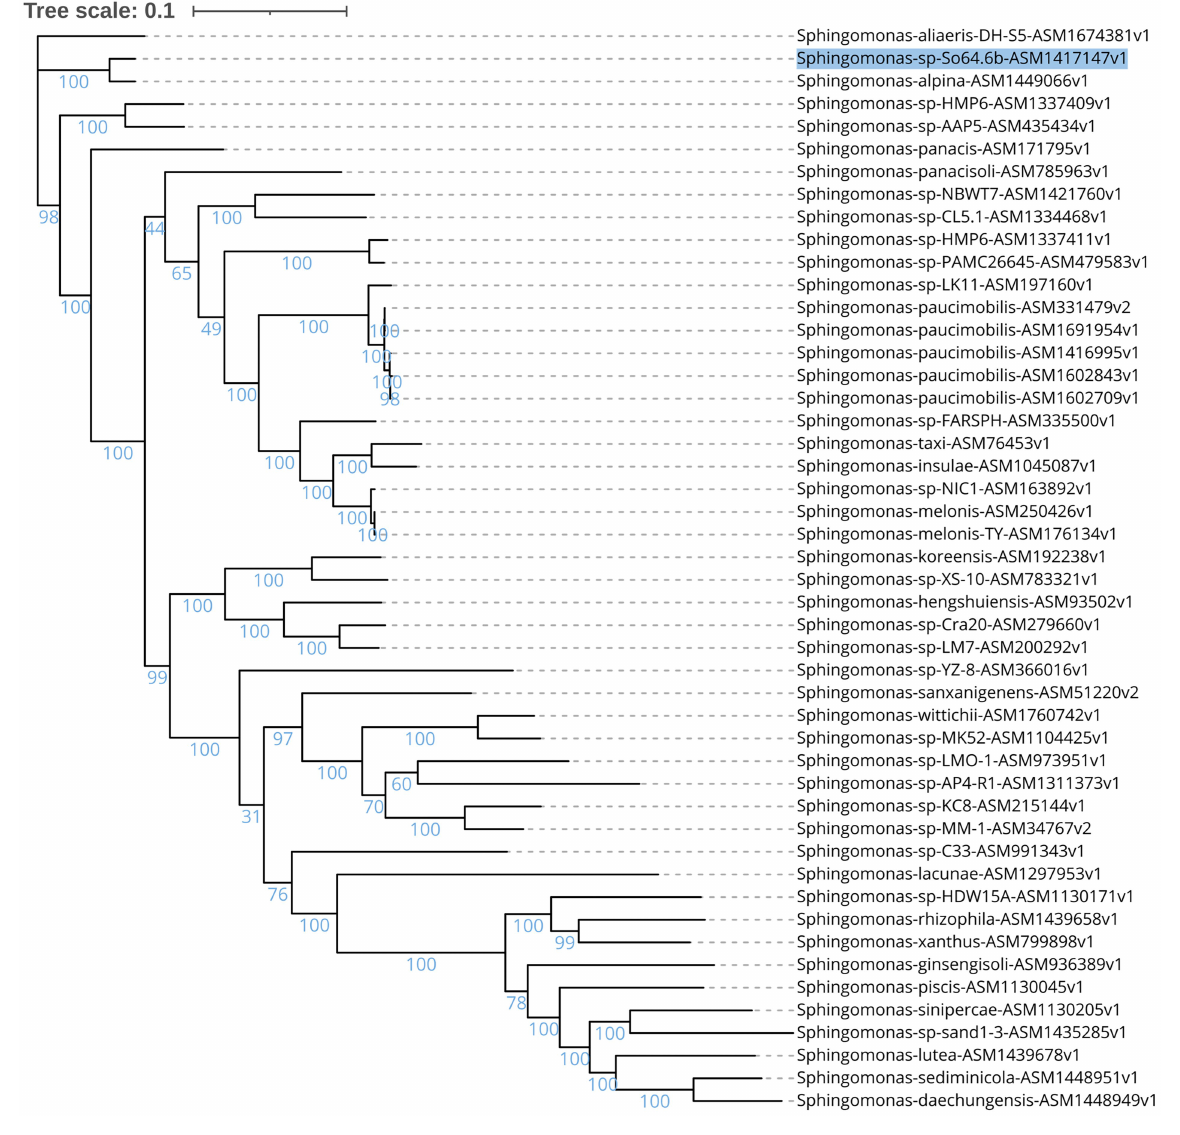
FIGURE 1 Maximun likelihood unrooted phylogenetic tree of proteome, based on sequences of concatenated amino acids from 126 ortholog genes present in 48 reference genomes from the Sphingomonas genus using RAxML. The accession number for the NCBI of each genome is present in the name. The branch lengths represent the number of substitutions per site (scale: 0.1 substitutions per site) and the percentage of the 1,000 replications bootstraps is also shown. Antarctic strain So64.6b is marked in